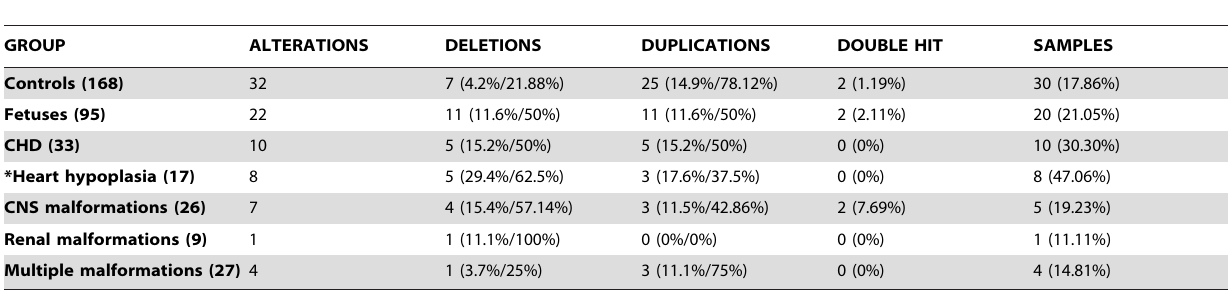
Table 3. Comparisons of rare copy number changes . 100 kb detected in the fetuses with congenital malformations and